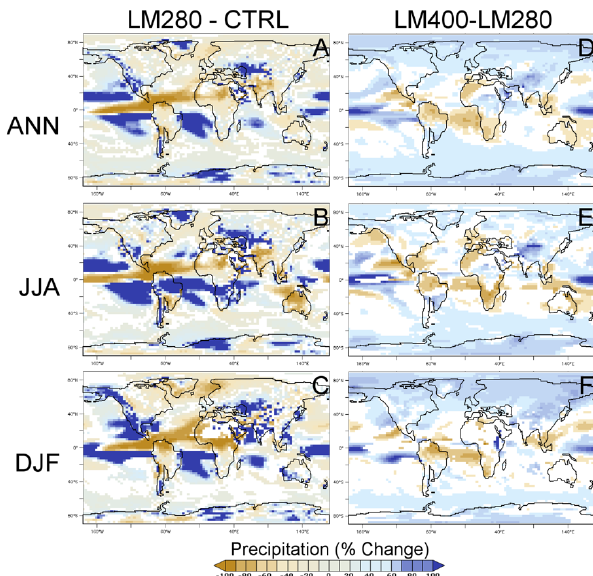
Fig. 5. Difference between the late Miocene and preindustrial sim- ulations (LM280-CTRL, left side) and between the late Miocene CO 2 simulations (LM400-LM280, right side) for mean precipita- tion. Only significant differences are shown using a 95% confidence interval Student’s t -test; white areas are not significant.